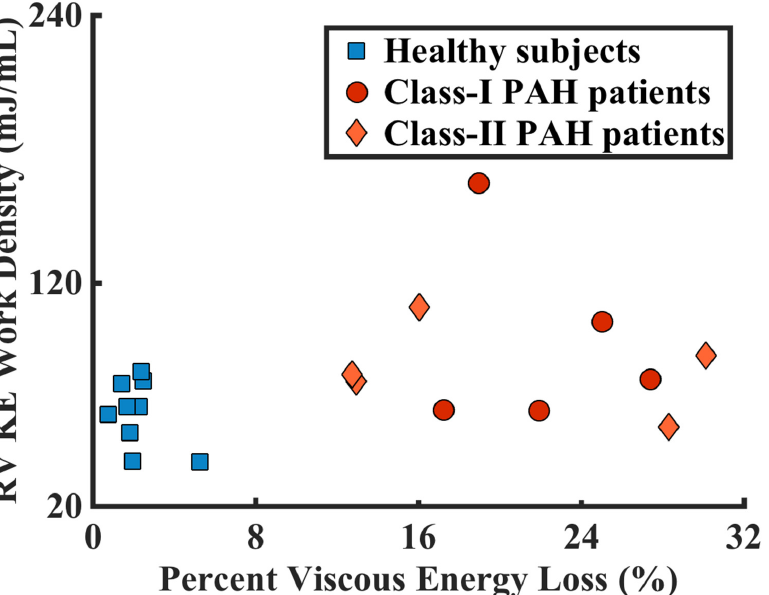
Fig 5. RV KE density and percent viscous energy loss together separated the PAH subjects from the healthy controls. In addition, PAH patients within the same functional classes had a wide